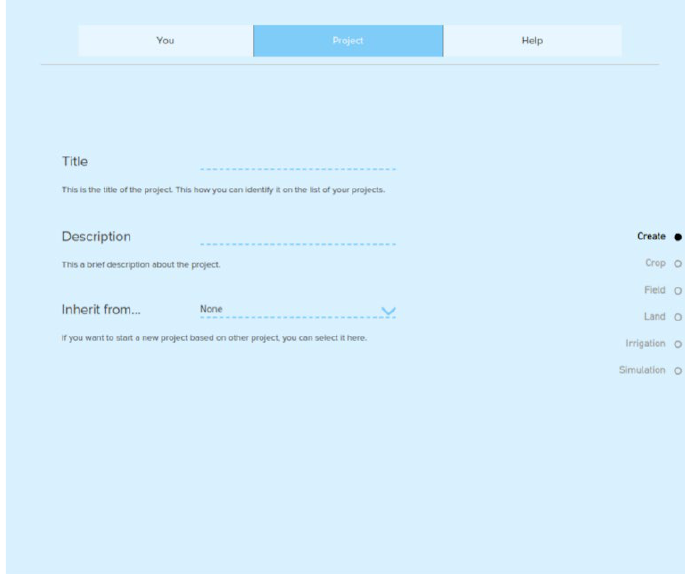
Figure 4. Program creation window